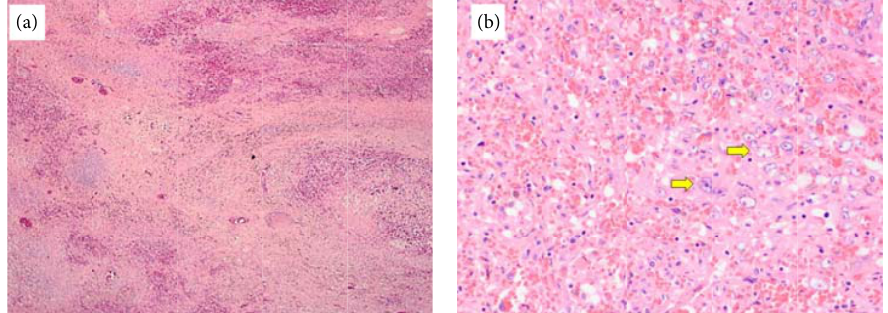
Figure 4: (a) Low power magnification (4x), showing effaced splenic architecture with large areas of hemorrhage. (b) Higher power magnification (20x) showing numerous large atypical cells (arrows).